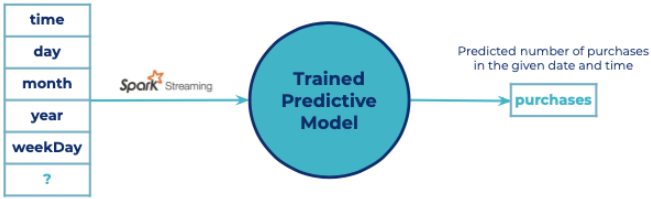
Figure 8. Prediction